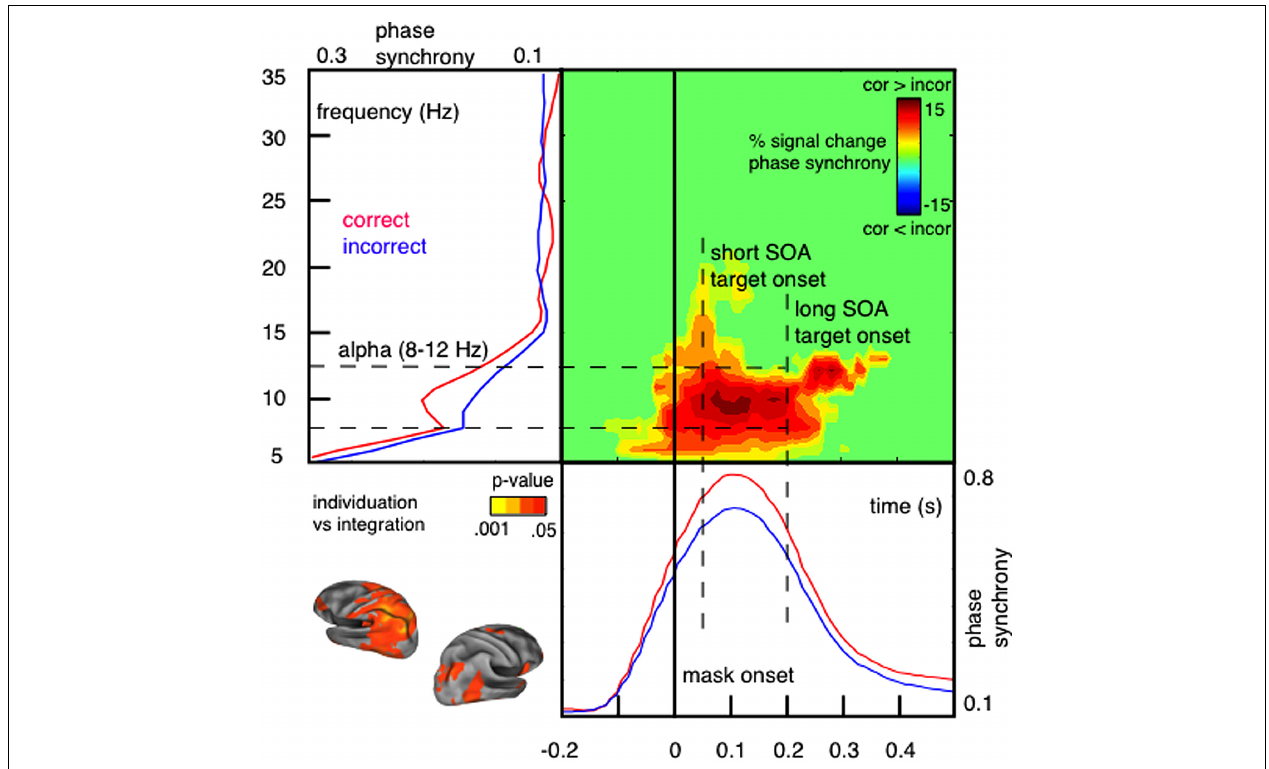
FIGURE 4 | Individuation and integration of visual signals depends on short-lived alpha phase synchrony shortly after stimulus onset. Phase synchrony [measured with inter-trial coherence (ITC); Makeig etal., 2004; also called phase-locking factor (PLF); Tallon-Baudry etal., 1996] is higher within correctly individuated trials compared to incorrect integration. Phase synchronization in response to the masking sequence is short-lived ( ∼ 100 ms; lower panel) and selective for alpha oscillations (8–12 Hz; left panel). Neural generators of this effect are located in